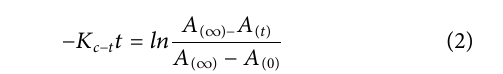
Frontiers in Physics |